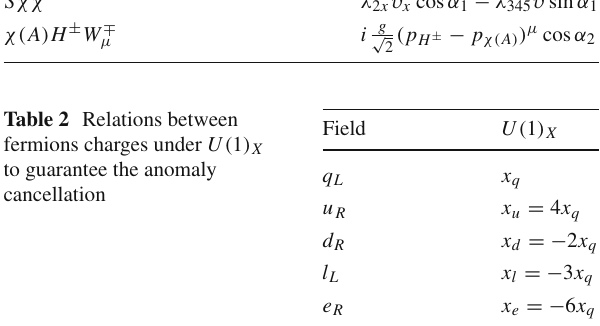
Fig. 1 R WW ∗ as a function of c α resents the allowed region by the signal R WW ∗ at 2 σ